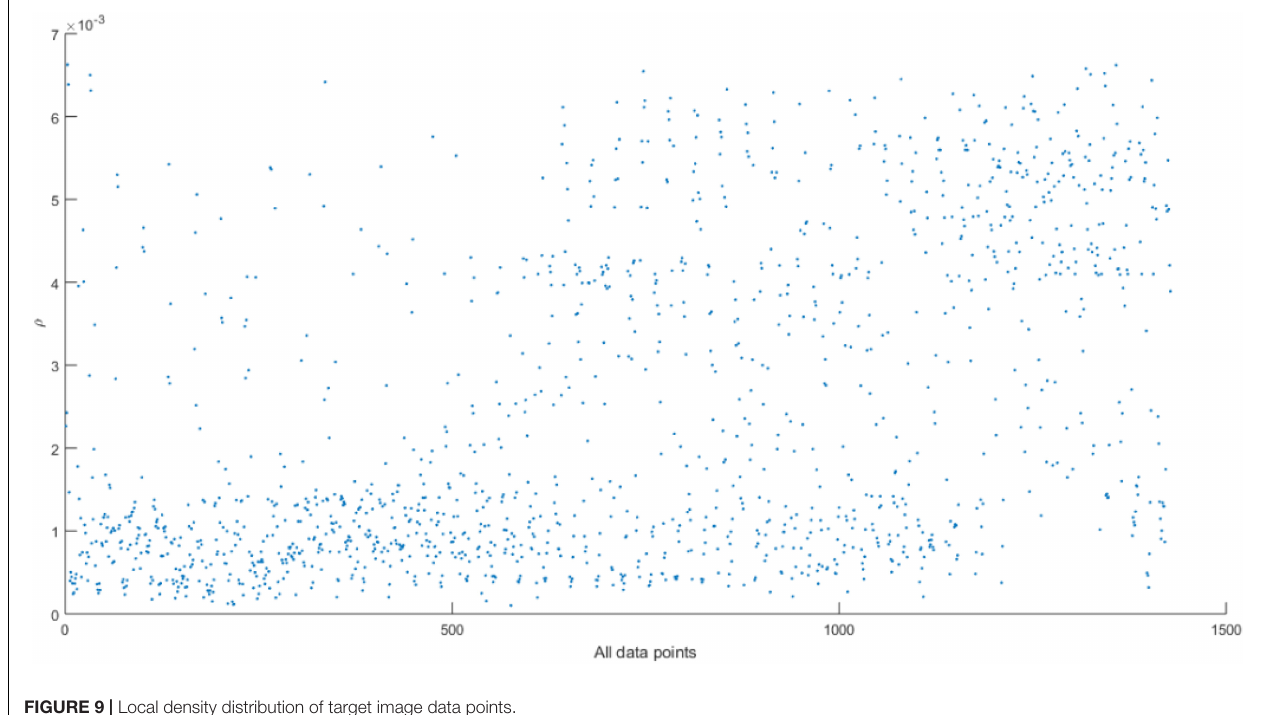
FIGURE 9 | Local density distribution of target image data points.